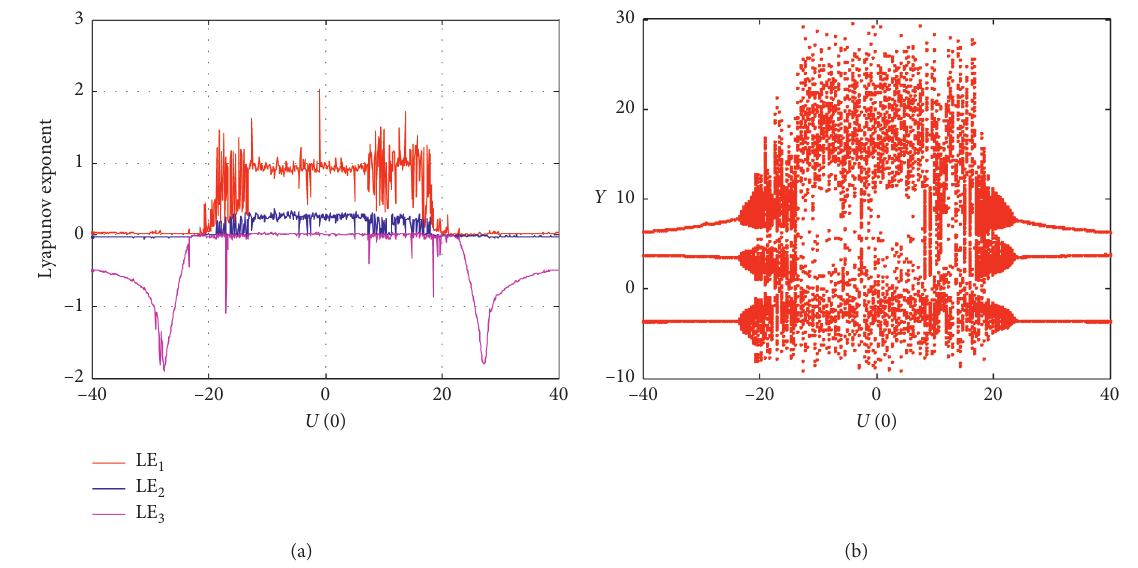
Figure 5: The occurrence of infinitely many hidden attractors of system (3) with respect to U (0): (a) the first three LEs, (b) the bifurcation diagram of the state variable Y .